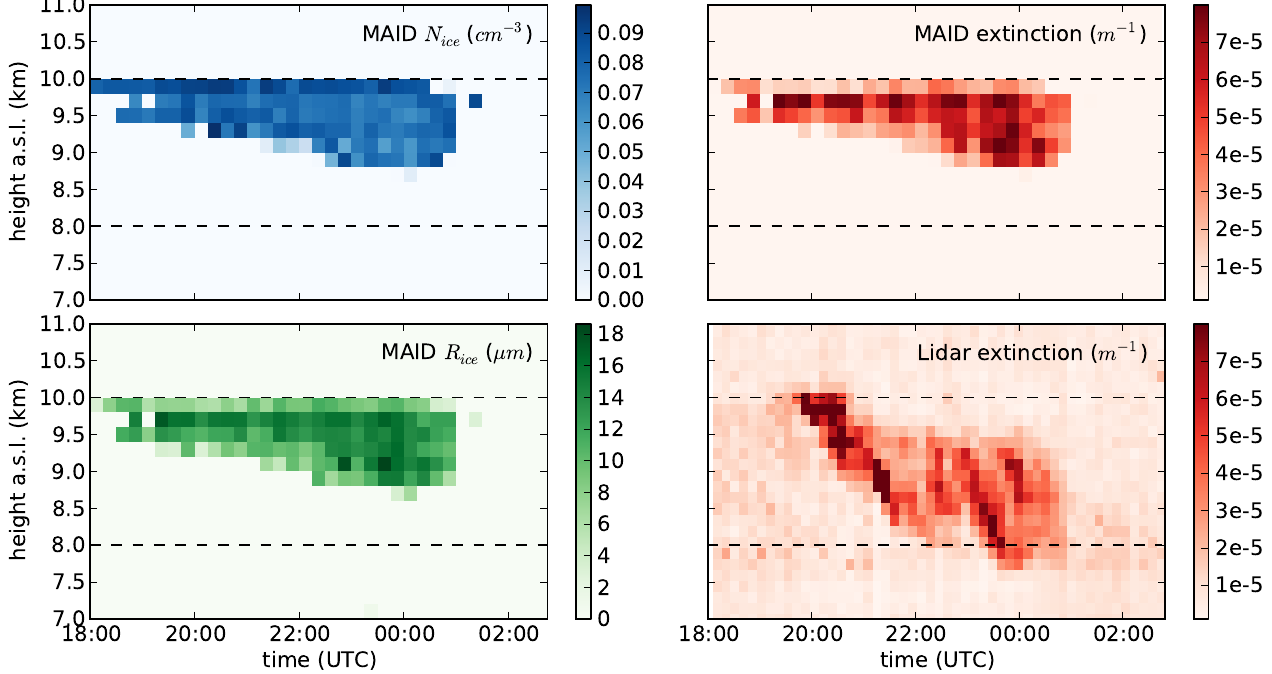
Fig. 8. Comparison of MAID simulated and observed induced cirrus cloud. Ice number concentration (N ice ), mean radius (R ice ), calculated extinction of MAID runs are shown as well as lidar-determined